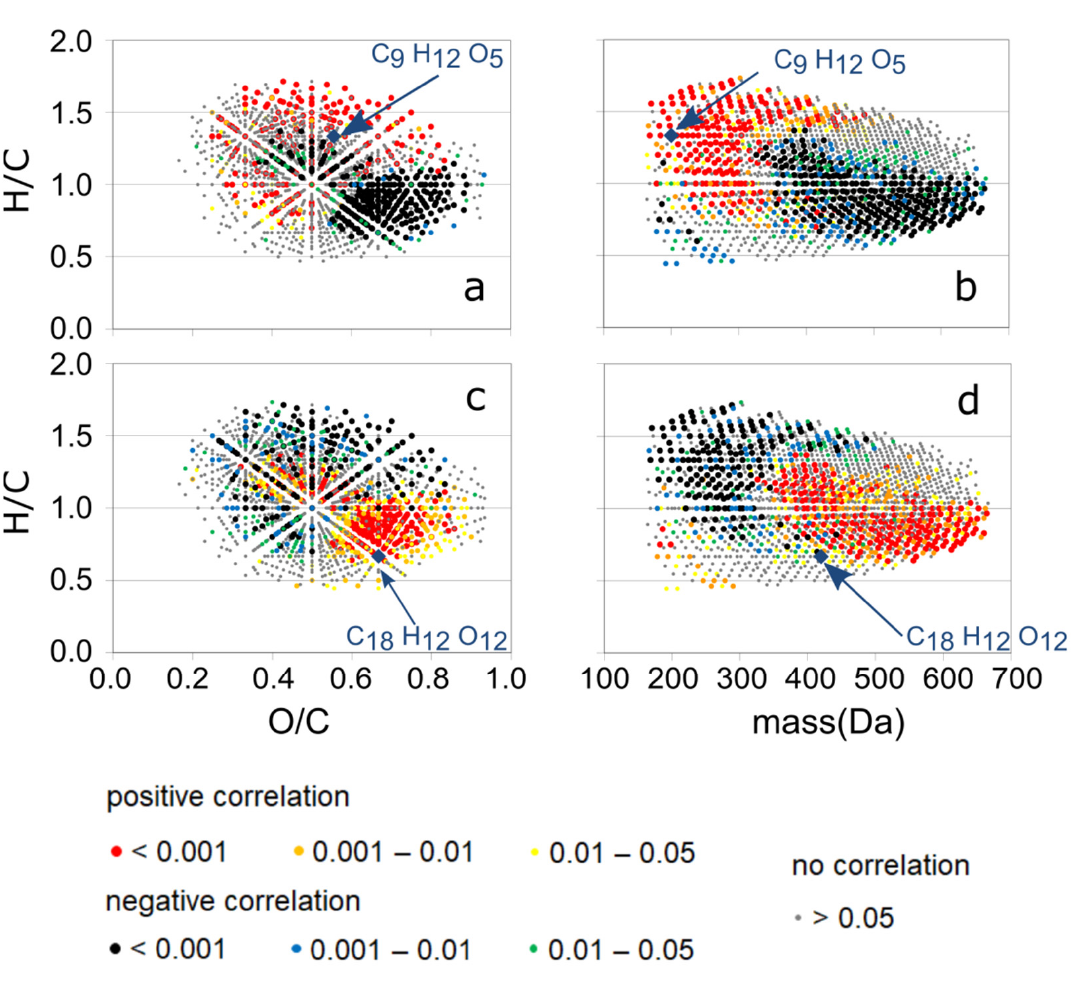
Figure 3. Spearman’s rank correlations between relative formula intensities as detected by FTICR MS and the PARAFAC components 1 ( a , b ) and 2 ( c , d ) of all CHO-MF found in all 48 samples. The legend shows positive and negative correlations and MF with no correlations ( p > 0.05) and different p -values ( p < 0.001, 0.001 < p < 0.01, and 0.01 < p < 0.05).